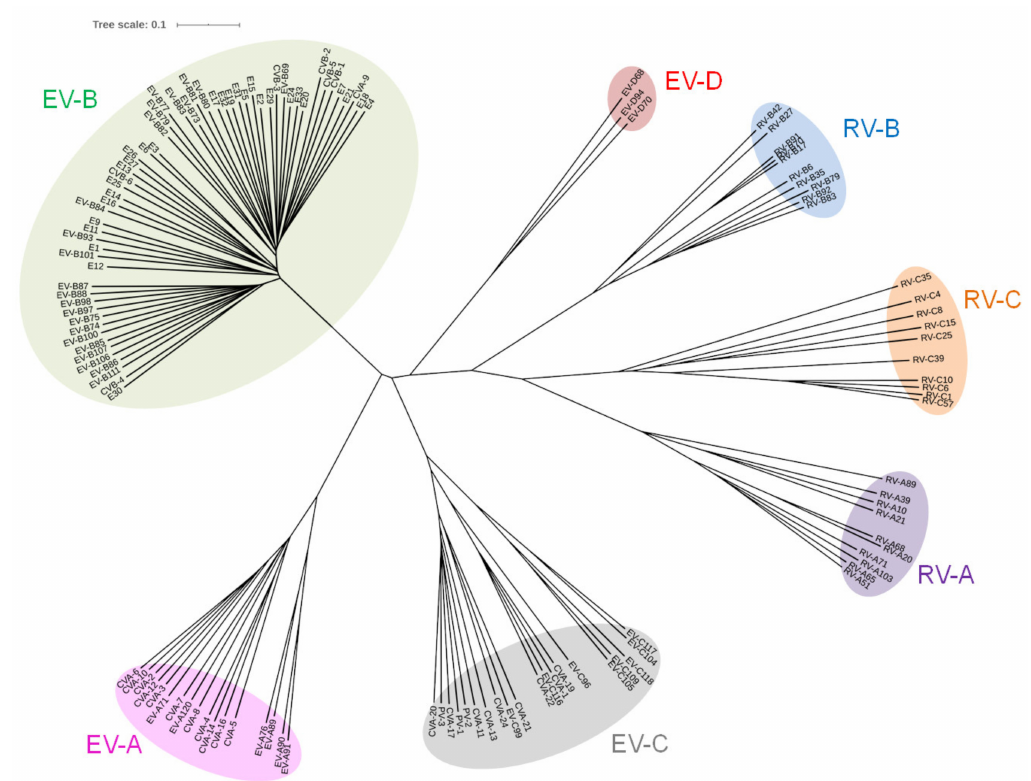
Figure 1. Evolutionary relationship of human enterovirus species. Molecular phylogenetic analysis of human enteroviruses was inferred using the Neighbor-Joining method (Letunic and Bork, 2019). Phylogenetic tree was constructed using complete sequence of enteroviruses aligned by muscle method. The optimal tree with the sum of branch length = 18.13314604 is shown. The tree is drawn to scale, with branch lengths in the same units as those of the evolutionary distances used to infer the phylogenetic tree. The evolutionary distances were computed using the Kimura 2-parameter method and are in the units of the number of base substitutions per site. This analysis involved 128 nucleotide sequences. All ambiguous positions were removed for each sequence pair (pairwise deletion option). There was a total of 8522 positions in the final dataset. Evolutionary analyses were conducted in MEGA X (Kumar et al., 2018). EV-A: Enterovirus A; EV-B: Enterovirus B; EV-C: Enterovirus C; EV-D: Enterovirus D; RV-A: Rhinovirus A; RV-B: Rhinovirus B; RV-C: Rhinovirus